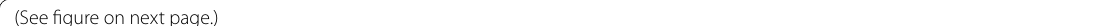
figure on next Fig. 4 The effects of lncRNA-ATB knockdown on the COM-induced EMT in HK ‐ 2 cells. a Morphological Changes of HK-2 cells exposed to 200ug/ ml COM or 10 ng/ml TGF-β1 for 48 h under light microscope. b,c The mRNA b or protein c levels of EMT markers in HK-2 cells exposed to 200ug/ ml COM or 10 ng/ml TGF-β1 for 48 h. d Quantitative results of EMT marker-protein levels. e The expression levels of E-cadherin and α-SMA were detected by immunofluorescence. All above the experiments were repeated 3 times, values are mean SD; * P < 0.05, ** P < 0.01 VS. sh-NC group, ± # P < 0.05, ## P < 0.01 VS. sh-NC COM group, ▲ P < 0.05, ▲▲ P < 0.01 VS. sh-NC TGF-β1 group, Scale bars 200 + + =